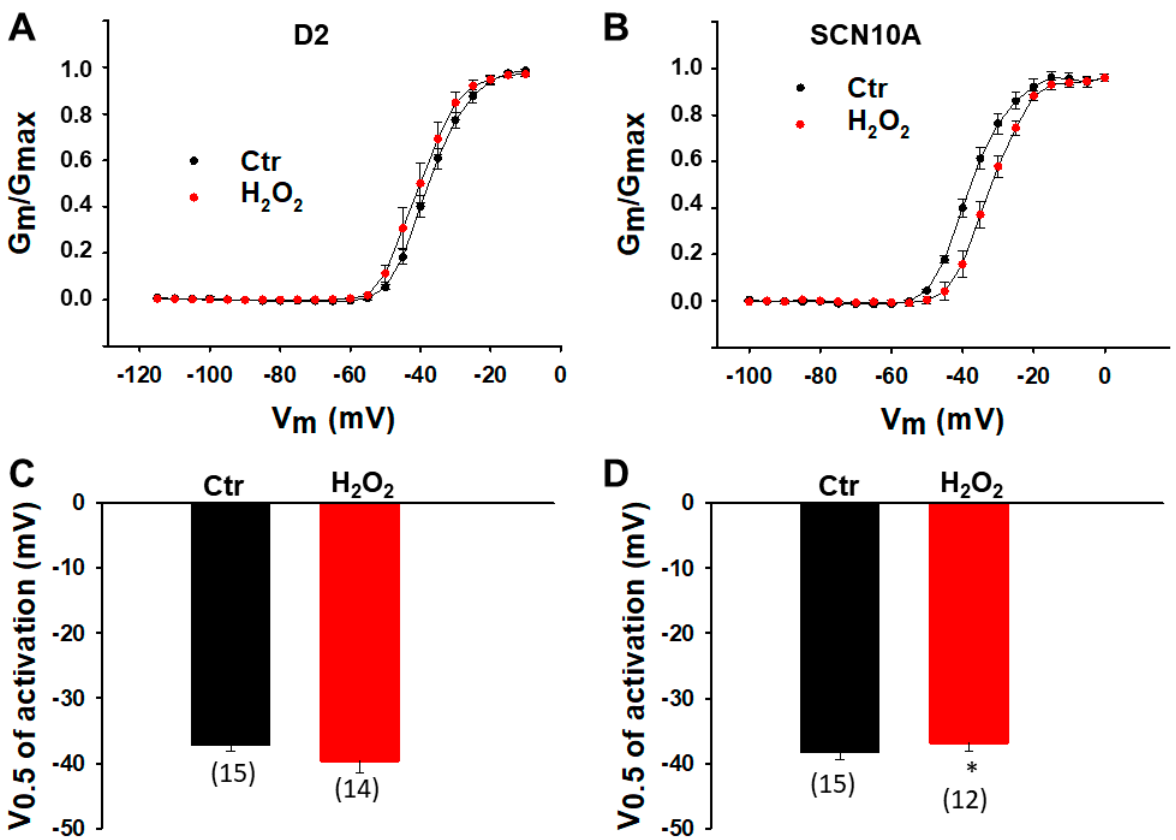
Figure 9. Effects of H 2 O 2 on activation of sodium channels in hiPSC-CMs from BrS-patient. Cells were treated with vehicle (Ctr) or H 2 O 2 (200 µ M) for 2 h. ( A ) Activation curves of peak sodium channel currents (I Na ) recorded in hiPSC-CMs by the D2 healthy donor. ( B ) Activation curves of peak I Na recorded in SCN10A-hiPSC-CMs. ( C ) Mean values of potential at 50% activation (V0.5) in hiPSC-CMs from D2 healthy donor. ( D ) Mean values of potential at 50% activation (V0.5) in SCN10A-hiPSC-CMs. Numbers given in ( C , D ) represent the number of cells of measurements also for ( A , B ). * p < 0.05 versus Ctr according to t -test for two groups.